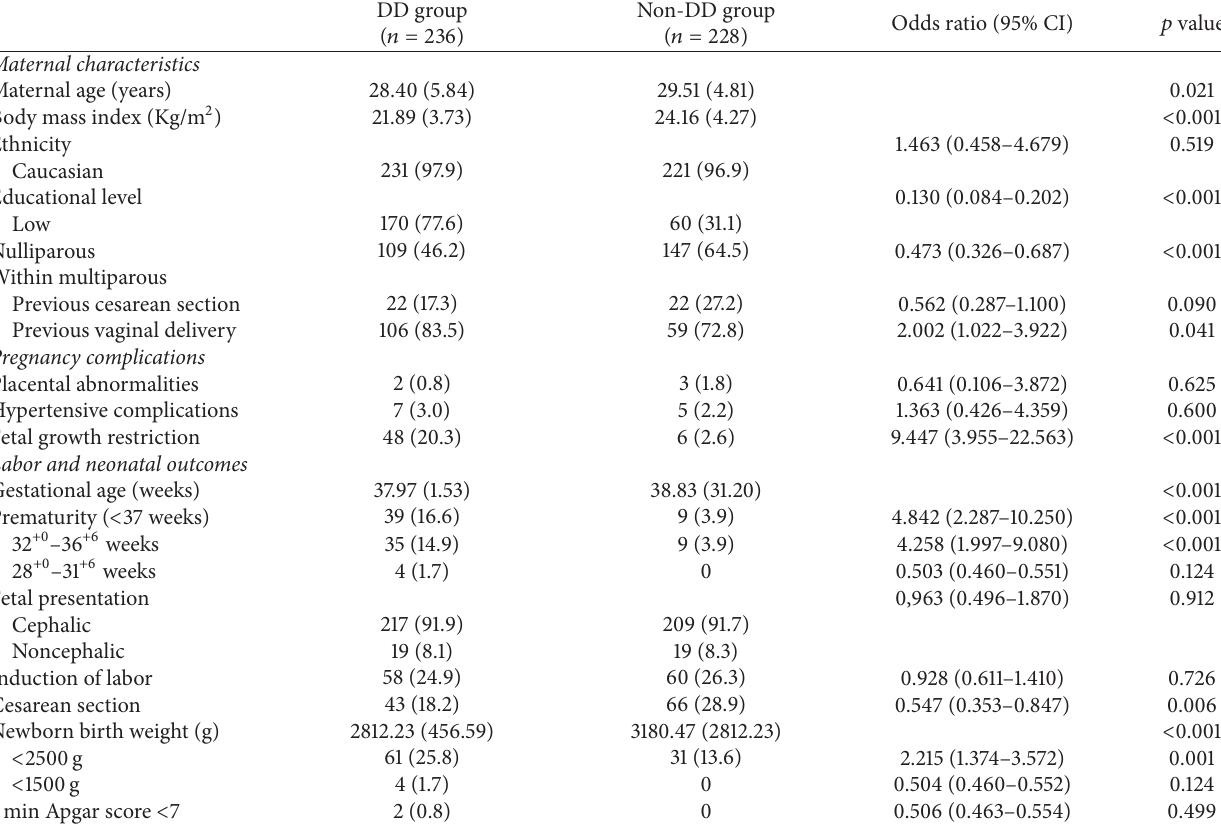
Table 1: Maternal characteristics and pregnancy and neonatal outcomes of the study groups.